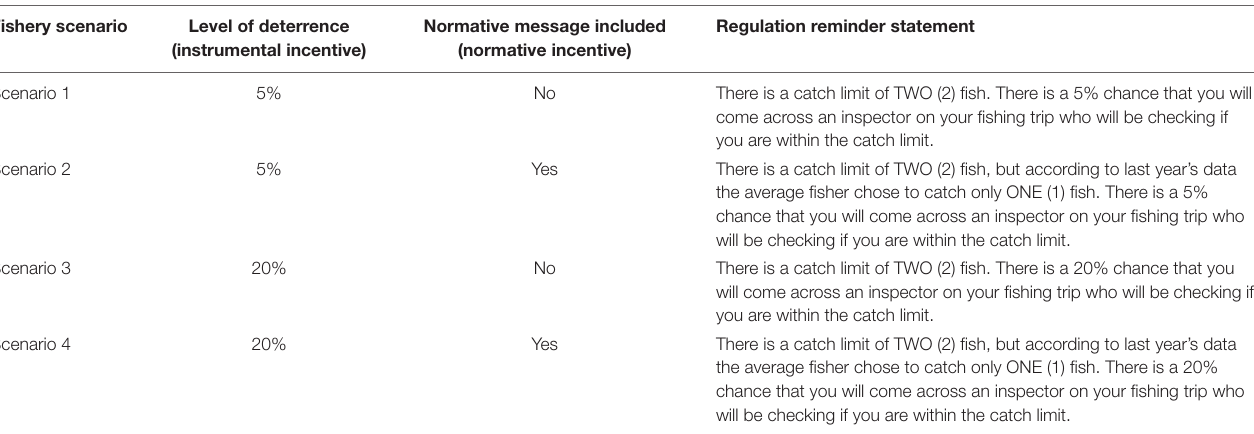
FIGURE 1 | Sequence of data collection within experiment in order. Segments colors represent each of the data collected; teal represents the catch/compliance data, pink represents risk preferences, green represents social norm values, purple represents ecological values and dark red represents personality types. TABLE 1 | Specifications of the fishery scenarios [adapted from Mackay et al.